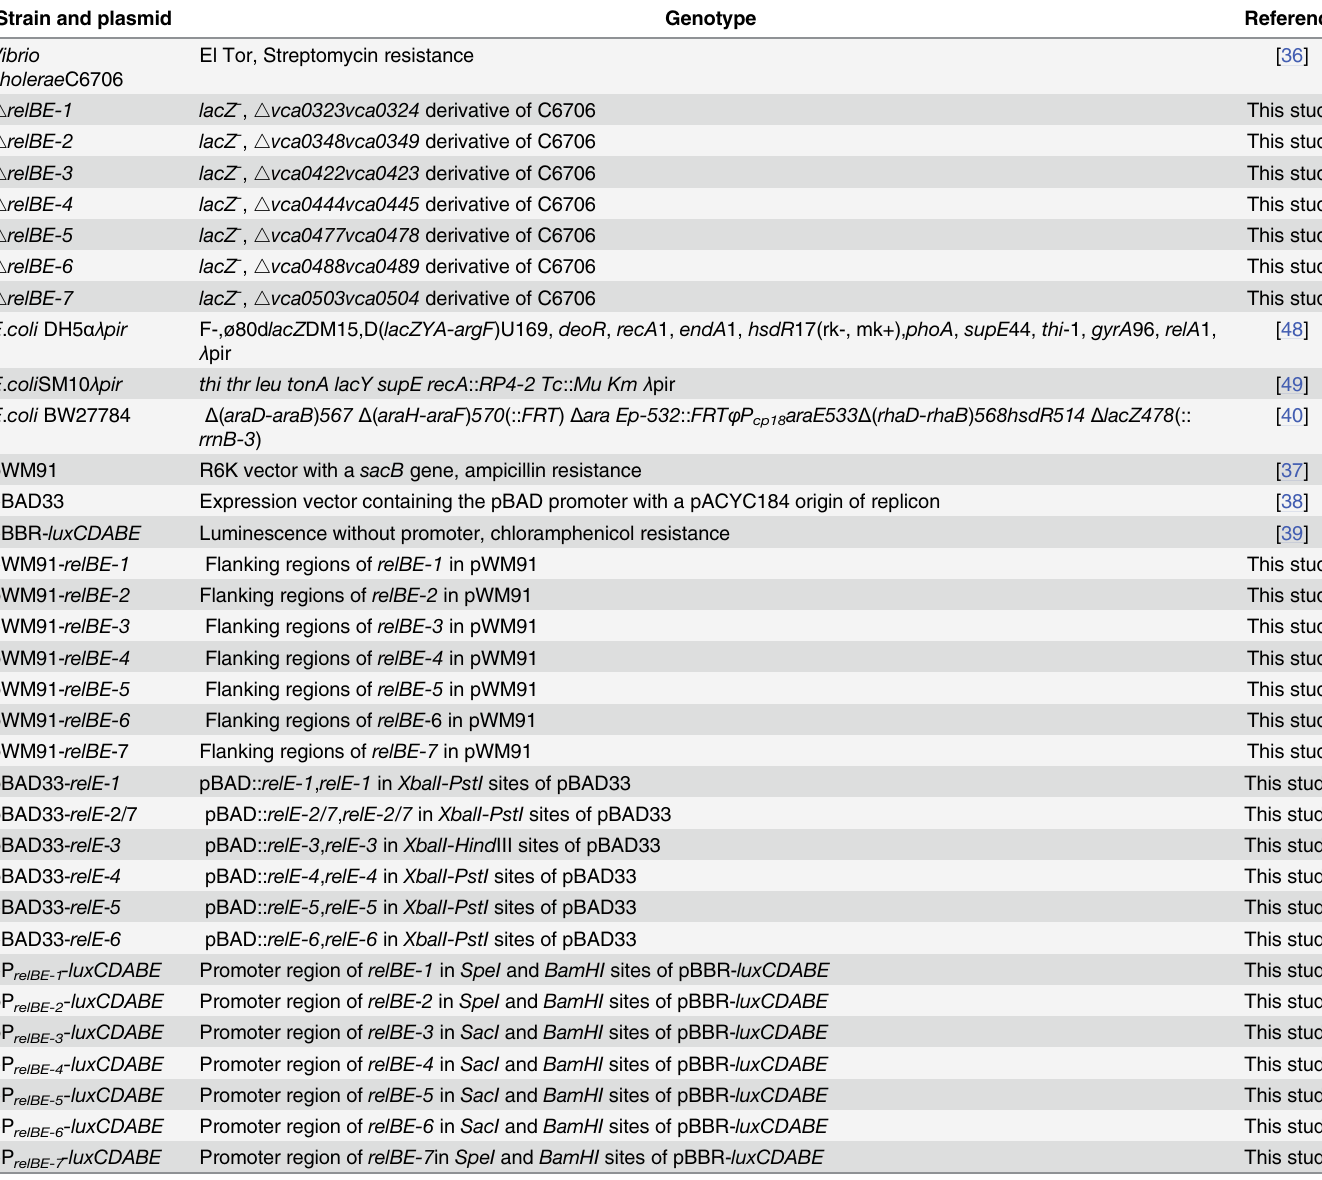
Table 1. Strains and plasmids used in this